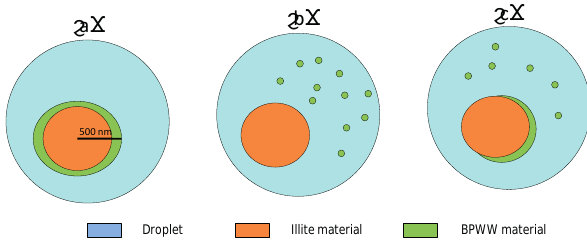
Figure 6. Theoretical forms of mixing of a spherical internally mixed illite–BPWW particle. (a) The illite-NX particle is com- pletely covered with BPWW material which does not dissolve in the droplet. (b) The BPWW material is completely dissolved in the droplet. (c) The BPWW material is partly dissolved and partly still on the illite-NX